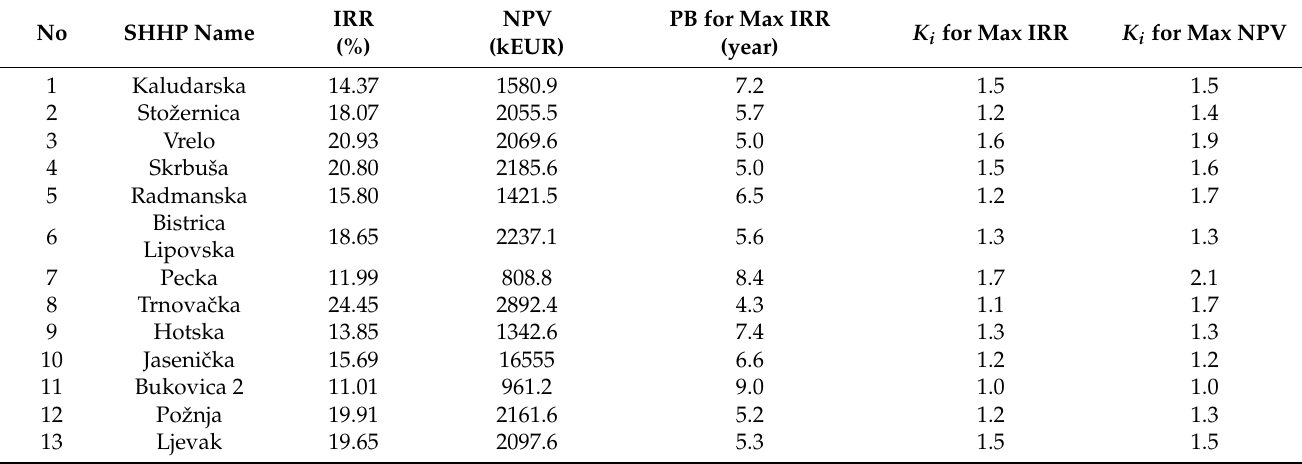
Table 7. Internal rate of return, net present value, payback period, and corresponding SHPP installed parameter for SHPPs from 0.4 MW to 2.4 MW—Group